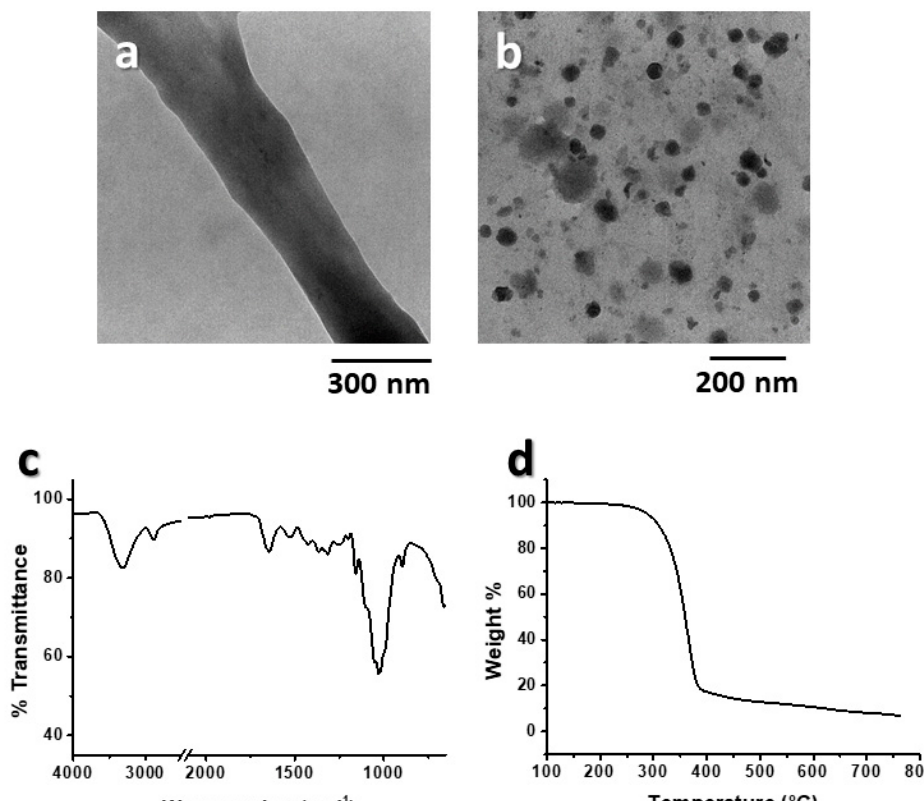
Figure 6. Bright field TEM images ( a , b ) FTIR spectrum ( c ) and TGA trace ( d ) of Figure 6. Bright fi eld TEM images ( a , b ) FTIR spectrum ( c ) and TGA trace ( d ) of BM60-3h.